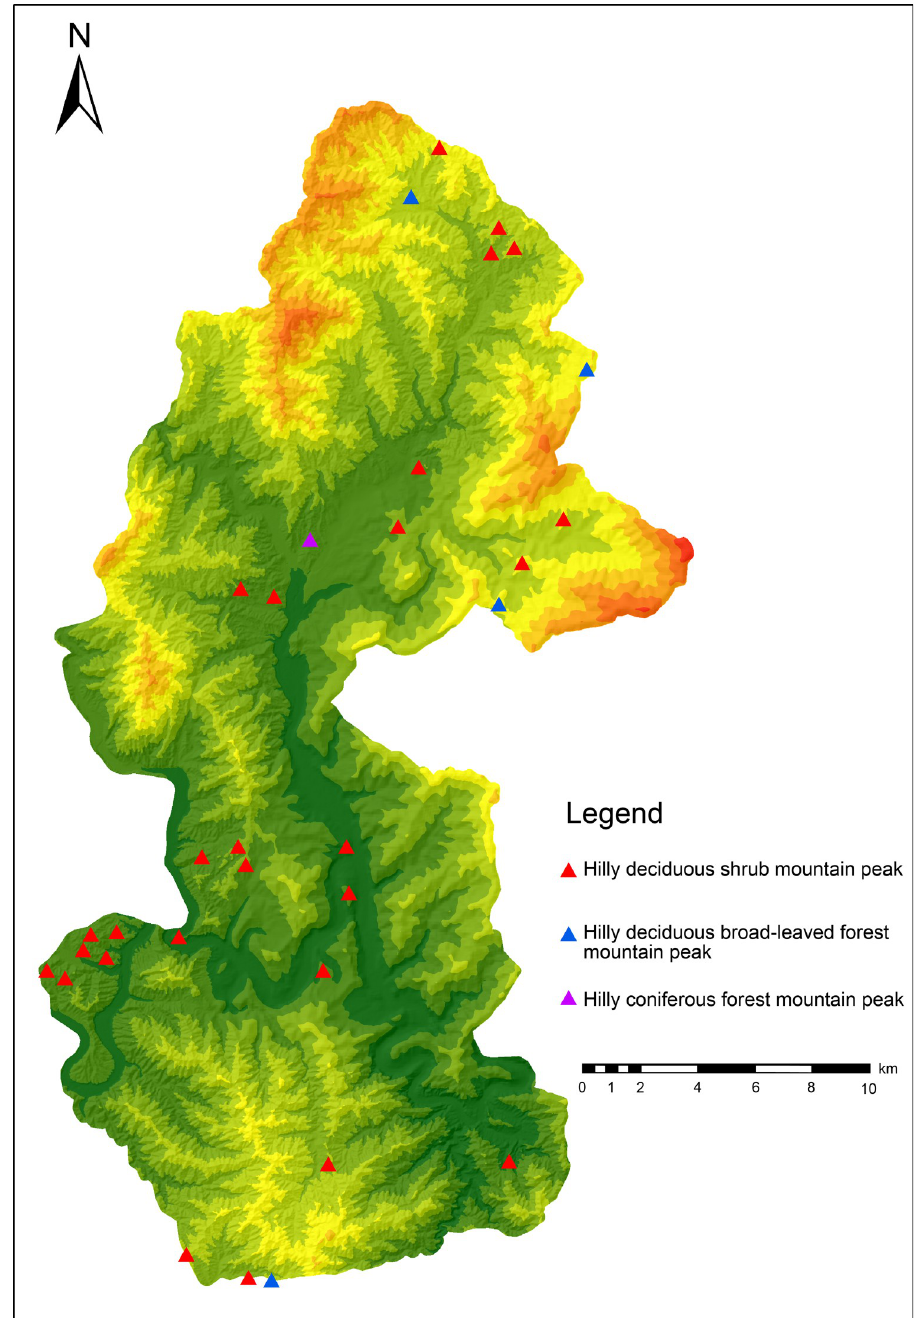
Fig 5. Distribution map of peaks in the hilly area of the Yesanpo National Park. (Republished from [https:// directory.eoportal.org/web/eoportal/satellite-missions/g/gaofen-2] under a CC BY license, with permission